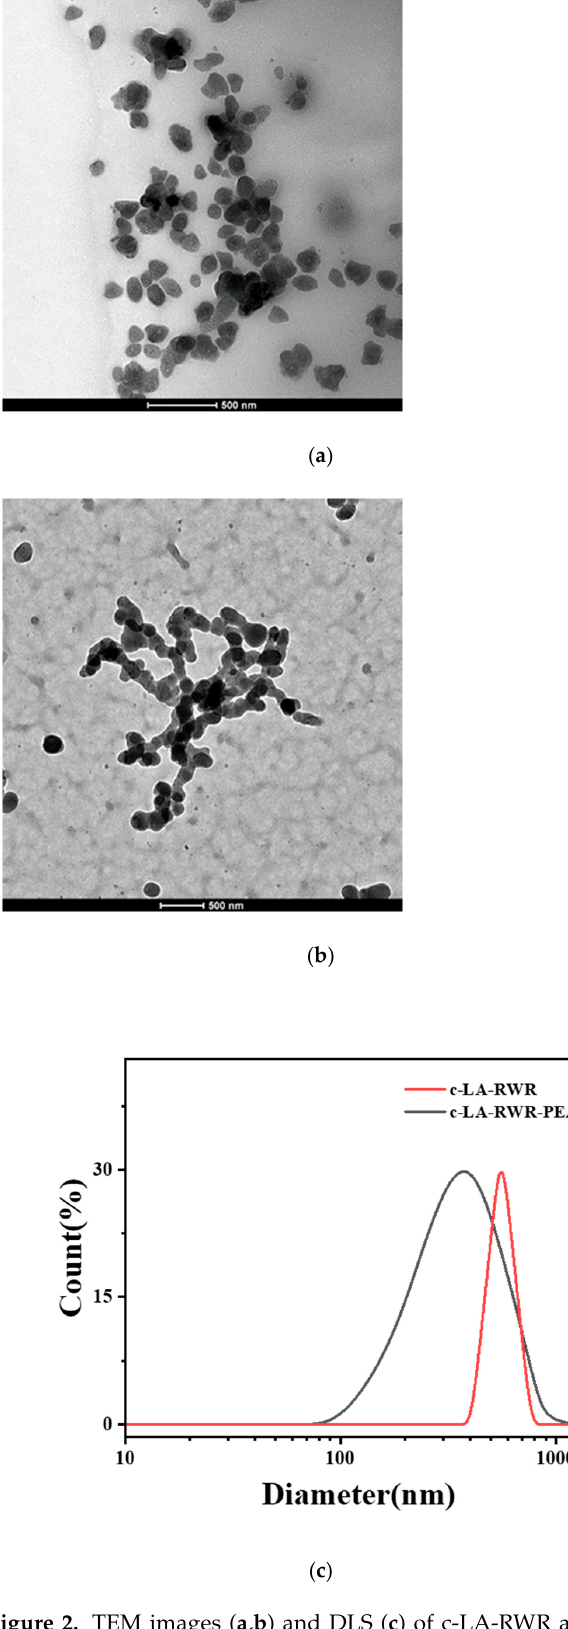
Figure 2. TEM images ( a,b ) and DLS ( c ) of c ‐ LA ‐ RWR and c ‐ LA ‐ RWR ‐ PEA nanoparticles. The peptide concentration used for crosslinking was 1 mg/mL.